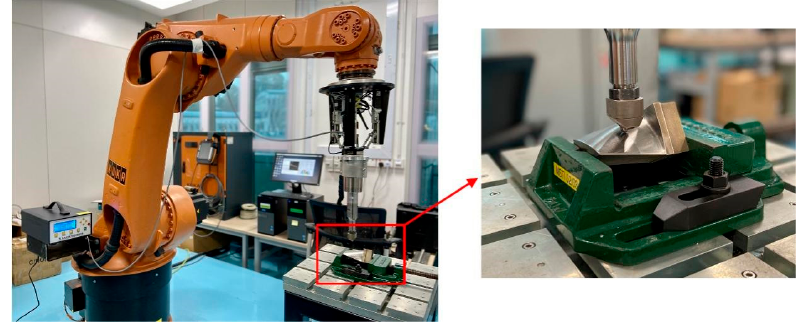
Figure 16. Robotic ultrasonic strengthening on aviation blade surface.